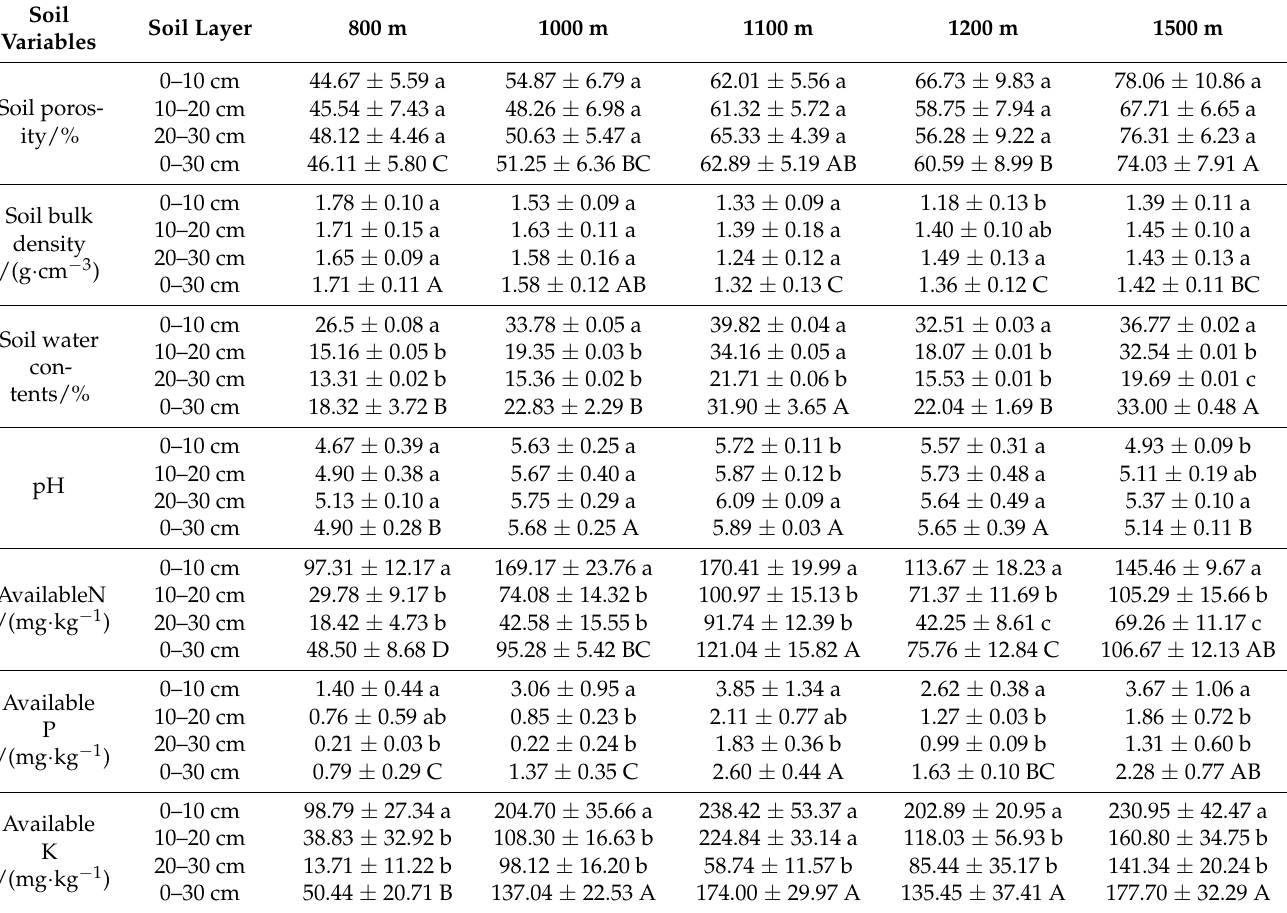
Table 3. Basic physical and chemical properties of the soils at different elevation